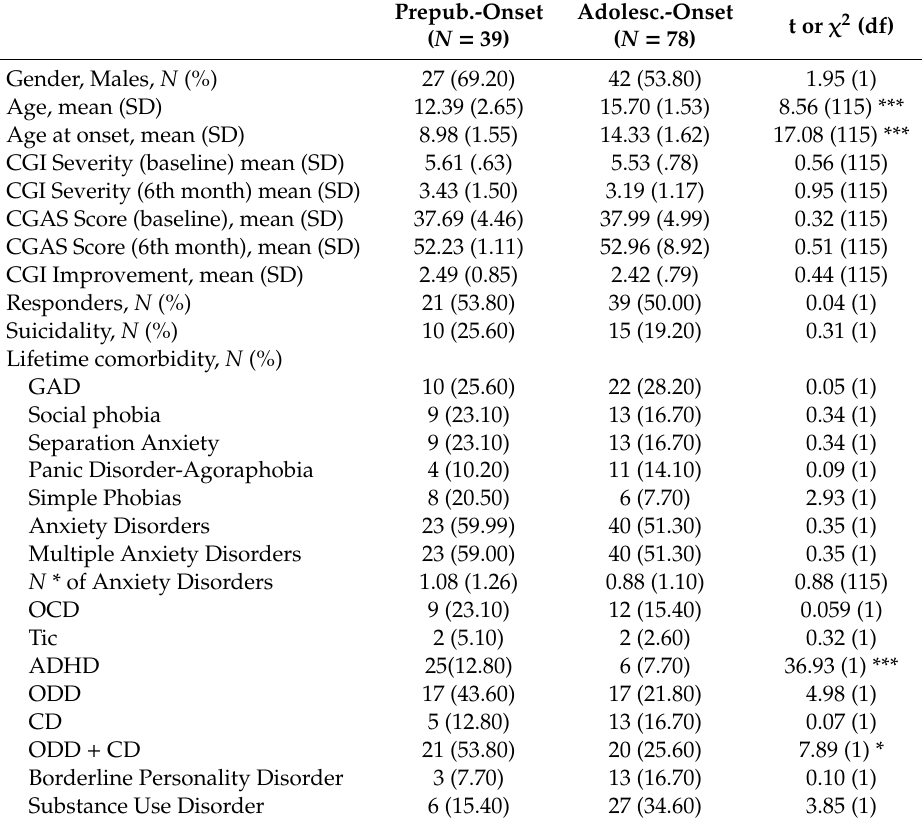
Table 2. Comparisons between prepubertal ( N = 39) and adolescent-onset ( N = 78).